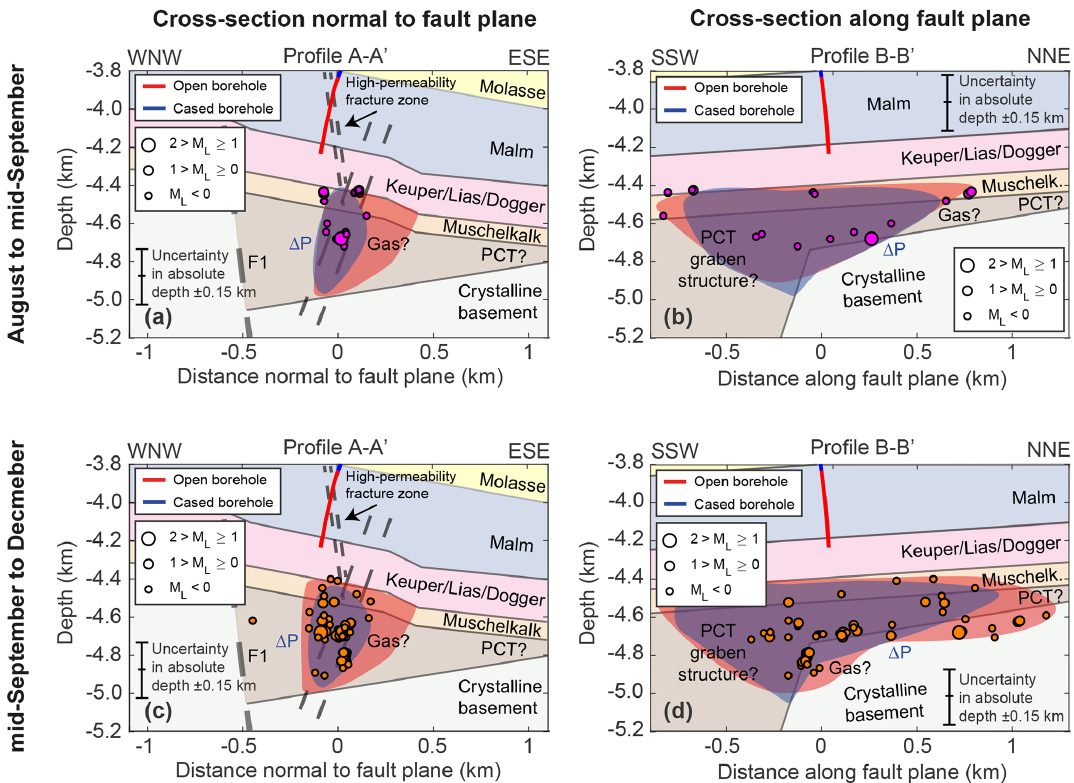
Figure 4. Conceptual model of the post-stimulation phase from August to December 2013. (a, b) Seismicity for the period 1 August to 15 September on a profile (a) normal to (A–A (cid:48) in Fig. 2) and (b) along (B–B (cid:48) in Fig. 2) the fault. The blue shaded area denotes the region affected by the direct pressurization, while the red shaded area depicts the possible location of the gas (shown in all subfigures). The seismicity in July is mainly located on the southwestern side of the borehole, whereas the seismic events after 1 August start to propagate to the northeast. (c, d) Seismicity of the period from 16 September to the end of 2013 on a profile (c) normal to and (d) along the fault. Borehole operations associated with some mud loss may be responsible for the increase in seismicity in September and October. The seismicity propagates further to the northeast but ceases during a production test at the end of October. Depth is defined relative to the top of the borehole (i.e., the free